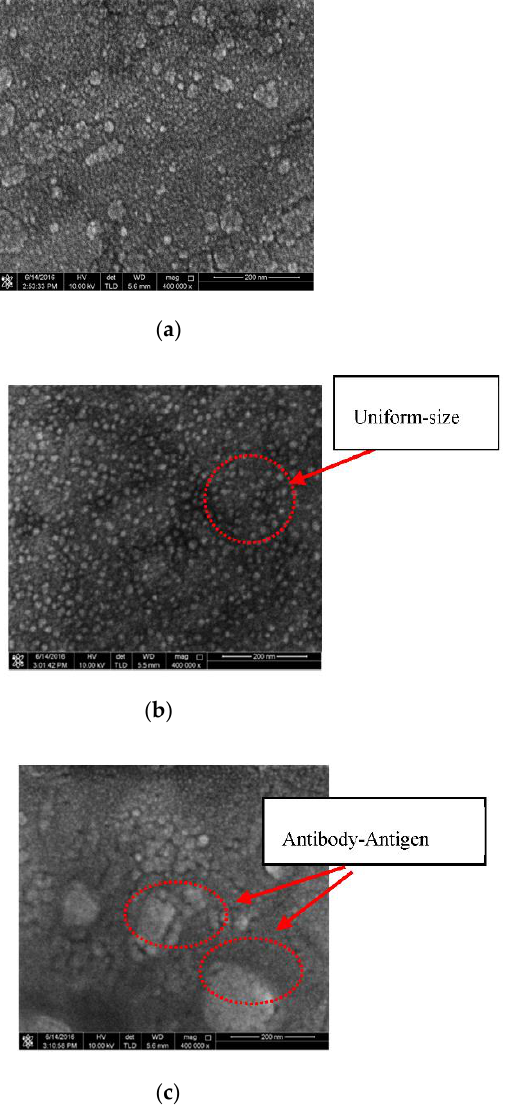
Figure 10. Top view of FESEM image of; ( a ) free sensor (Phase I); ( b ) sensor modified with NS1 antibody (Phase II); and ( c ) modified-antibody sensor with NS1 protein.